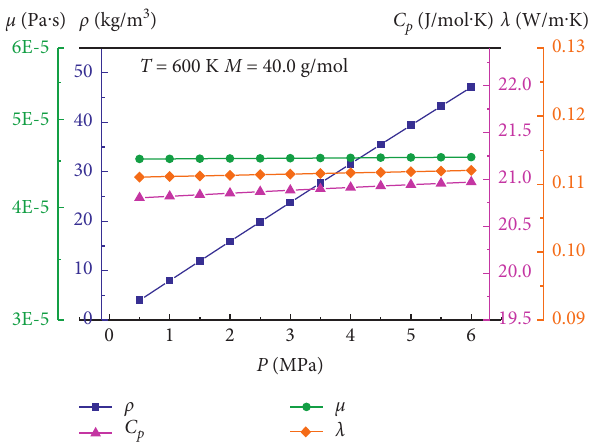
Figure 6: Variation of properties for helium-xenon mixture with